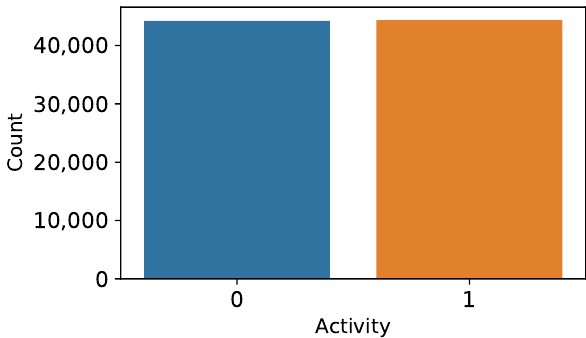
Figure 2. Bar chart-based dataset balancing analysis using the target labels. Correlation analysis of the features of our study dataset is visualized in Figure 3. The analysis shows that a high positive correlation value of 0.6 is achieved by the features acceleration-y and activity, and an acceptable correlation value of 0.3 is achieved by the features acceleration-z, gyro-x, and gyro-y. A high negative correlation value of − 0.6 is achieved by the features acceleration-x and wrist. This analysis concludes that the values of accelerometer sensor features have higher correlations than gyroscope sensor features. The dataset features have high relevance values to the target feature activity in this analysis.